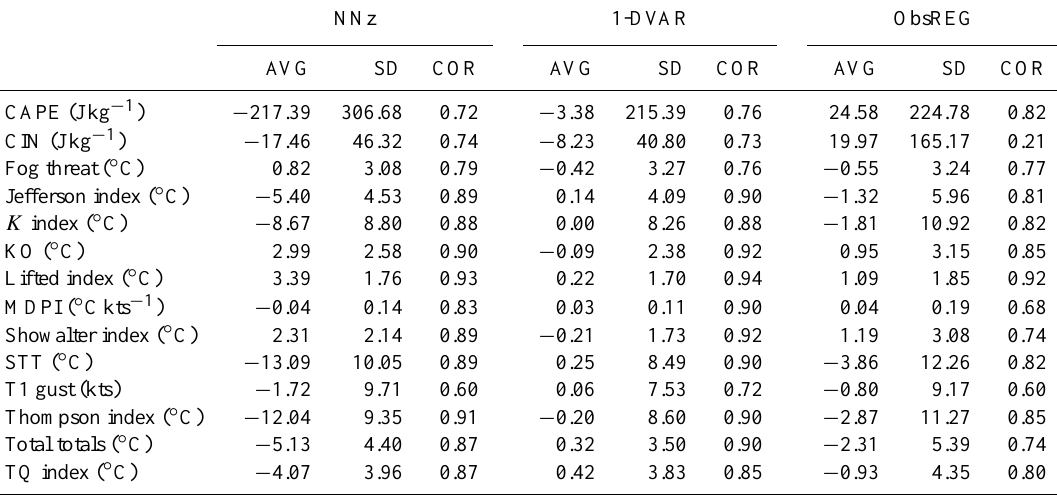
Table 3. As in Table 2 but for Lindenberg (233 radiosondes). Average (AVG) FI difference (radiosonde–MWRP), standard deviation (SD), and correlation coefficient (COR) are shown.